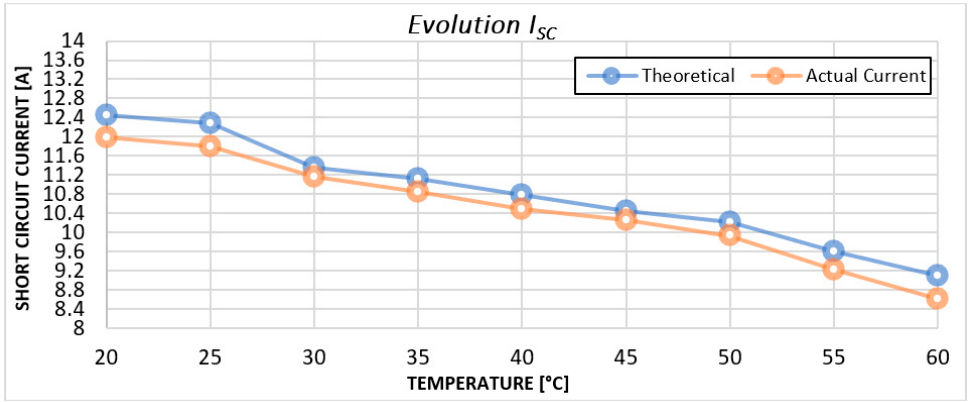
Figure 5. Plot representation of the temperature influence to the I SC characteristics of the PV generator.